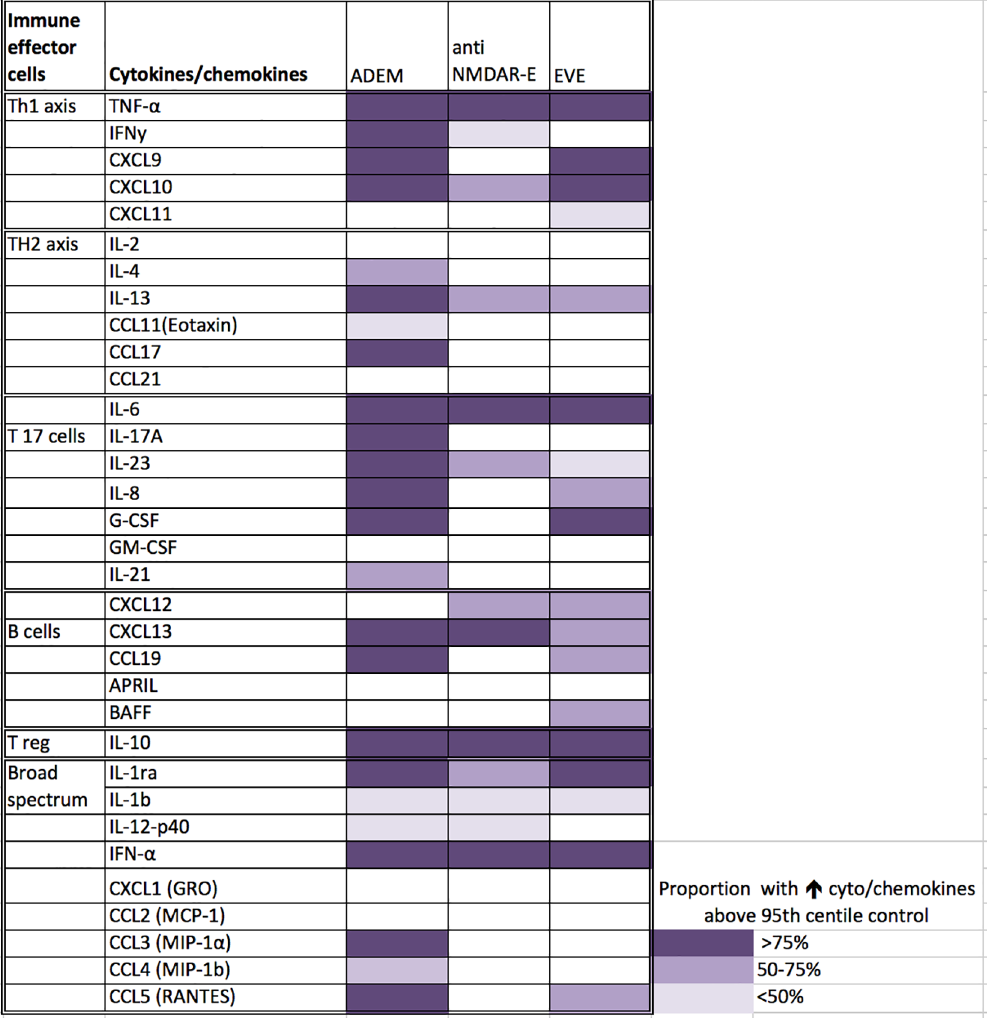
helper subsets (Th1, Th2, T reg, Th17, B cell and other cytokines and chemokines) in ADEM patients unlike anti- NMDAR E and EVE. # Cytokine/chemokines were shaded only if these molecules were statistically significantly elevated in different encephalitis groups compared to controls (p <